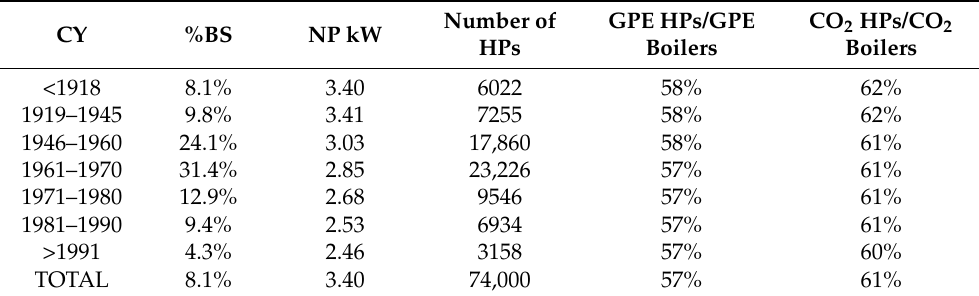
Table 8. Distribution, by year of building construction CY in Salerno, of the 74,000 selected HPs, percentage ratio of global primary energy from fossil fuels and emissions of CO 2 of heat pumps to that of boilers; (generation fraction from RES 35%, grid losses 10%, COP at design temperature of 2 ◦ C), portion of building stock %BS, nominal power NP.